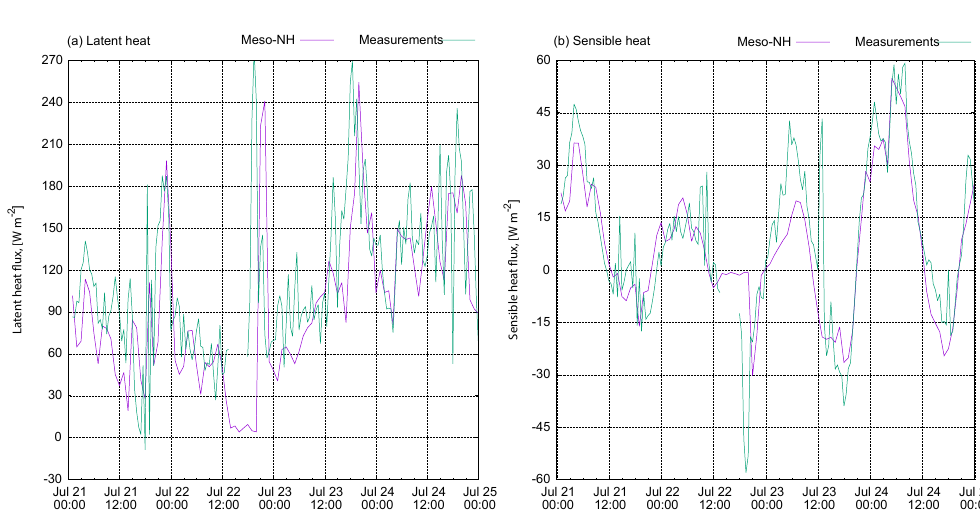
Figure 7. Observed and simulated latent (a) and sensible (b) heat fluxes at Montante floating